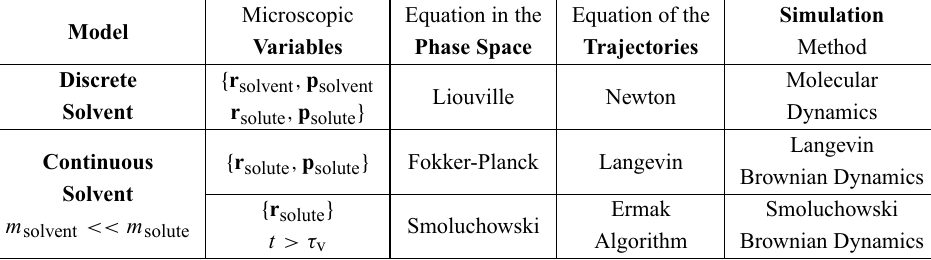
Fig. 3 – Various levels of description for the description of the dynamics of ions in